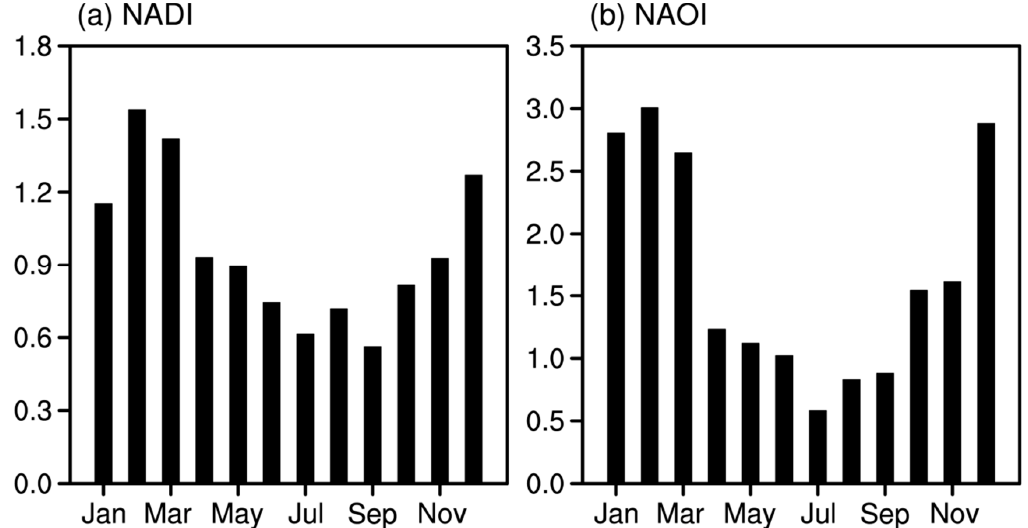
Figure 1. ( a ) Seasonal variations of the standard deviation of the NADI; ( b ) as (a), but for NAOI.